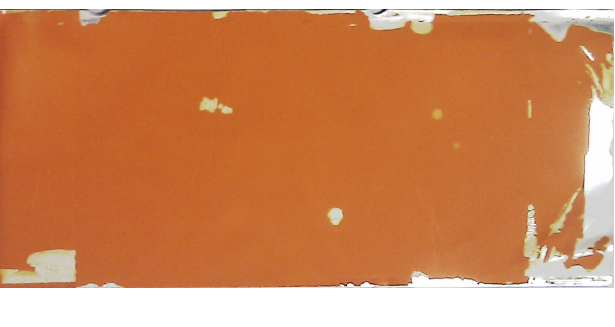
Figure 3. Mechanical damage to several initial TLC plates after 10 runs of the shock